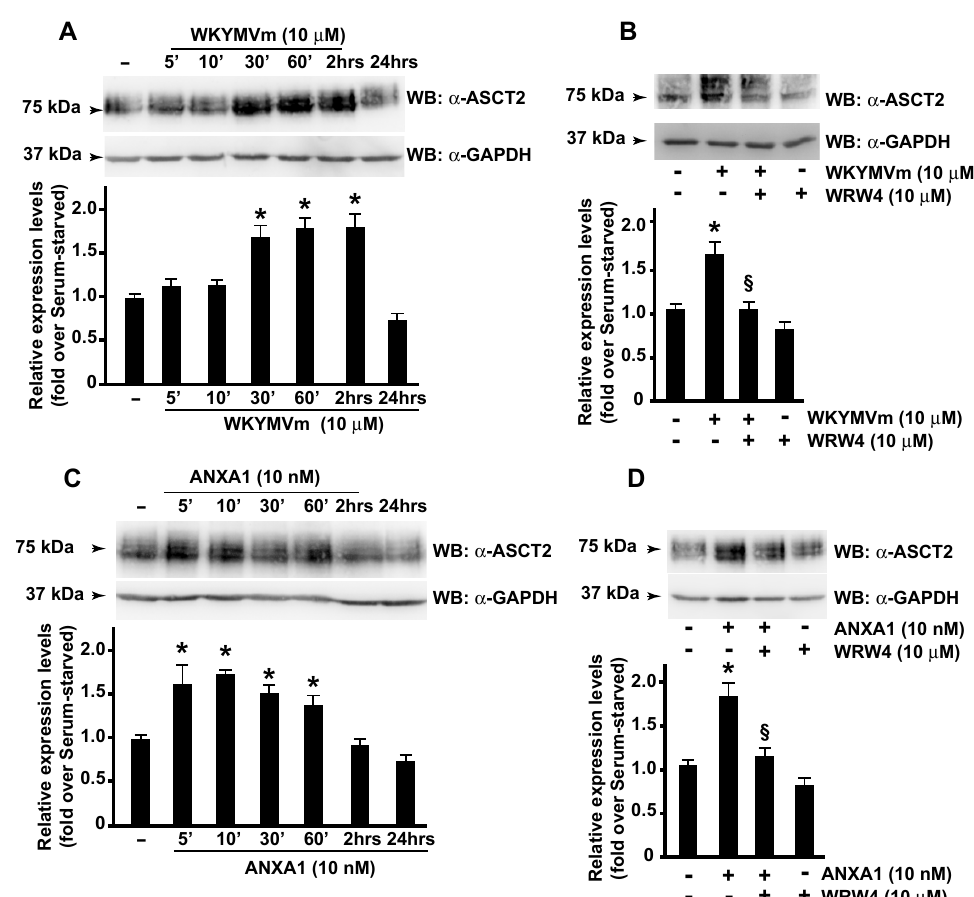
Figure 3. FPR2 stimulation induces ASCT2 expression. Growth-arrested CaLu-6 cells were stimulated for the indicated times with WKYMVm (Panel A ) or ANXA1 (Panel C ) or preincubated with WRW4 before stimulation (Panels B , D ). Fifty micrograms of whole lysates were resolved on 10% SDS-PAGE and incubated with an anti-ASCT2 ( α -ASCT2) antibody. An anti-GAPDH ( α -GAPDH) antibody was used as a control for protein loading. Bar graphs are representative of three independent experiments. * p < 0.05 compared to unstimulated cells. § p < 0.05 compared to stimulated cells. Carbamoyl-phosphate synthetase 2, aspartate transcarbamylase, and dihydroorotase (CAD) form a multifunctional enzyme that participates in the three initial speed-limiting steps of the de novo synthesis of pyrimidine nucleotides in mammals; it is capable of supplying all pyrimidine ribonucleotides and deoxyribonucleotides for RNA and DNA biosynthesis. In resting cells, CAD is mainly localized in the cytoplasm. Its translocation to the nucleus occurs as a result of the entry of the cells into S phase by MAPK that phosphorylate CAD at the Thr 456 residue. As cells exit S phase, CAD is dephosphorylated at this residue and phosphorylated at Ser 1406 by PKA, returning the pathway to its basal activity [70]. The phosphorylation at the Ser 1859 residue on CAD by S6 kinase 1 (S6K1), a downstream ribosomal protein target of mTORC1, stimulates the first three steps of the de novo pyrimidine synthesis and thus helps to advance the cells’ overall progression through S phase of the cell cycle [71,72]. Therefore, we analyzed the Ser 1859 phosphorylation of CAD in FPR2-stimulated cells, and we observed that either WKYMVm or ANXA1 induced a time-dependent increase in phospho-CAD (Figure 5A,C). Preincubation with WRW4 before stimulation with the two agonists prevented CAD activation (Figure 5B,D), proving that it depends on FPR2